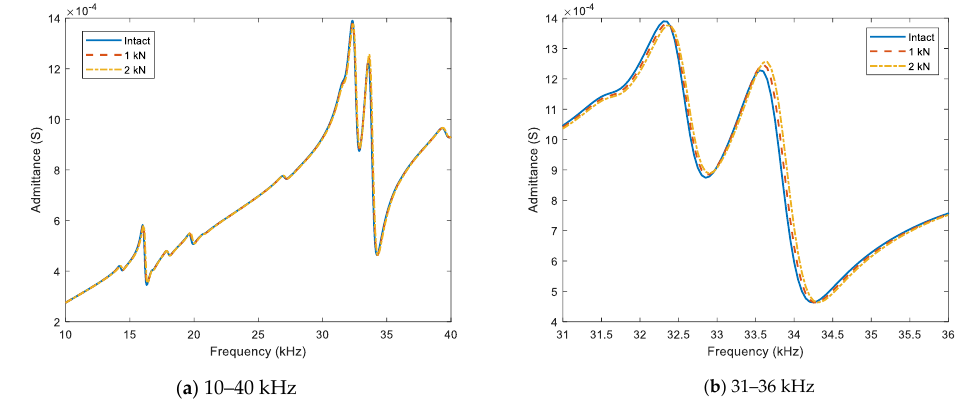
Figure 4. Numerical admittance responses under ascending loading.